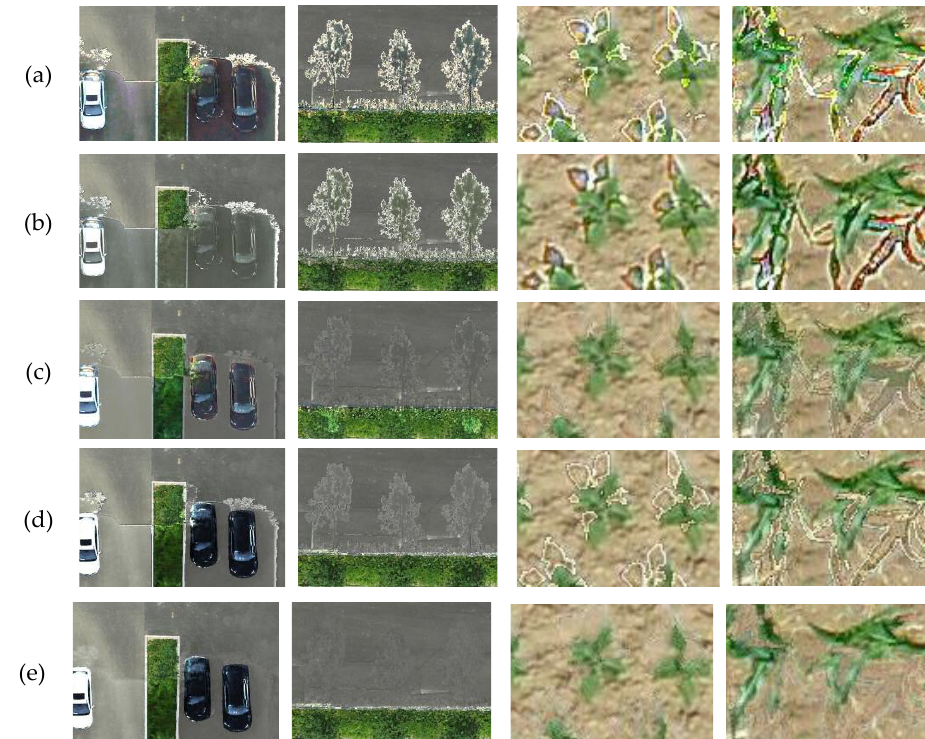
Figure 8. The compensation results of different methods applied to the four study regions: (a) Sil- va ’ s method; (b) Gilberto ’ s method; (c) Liu ’ s method; (d) the proposed method (without penumbra compensation); (e) the proposed method (with penumbra compensation).